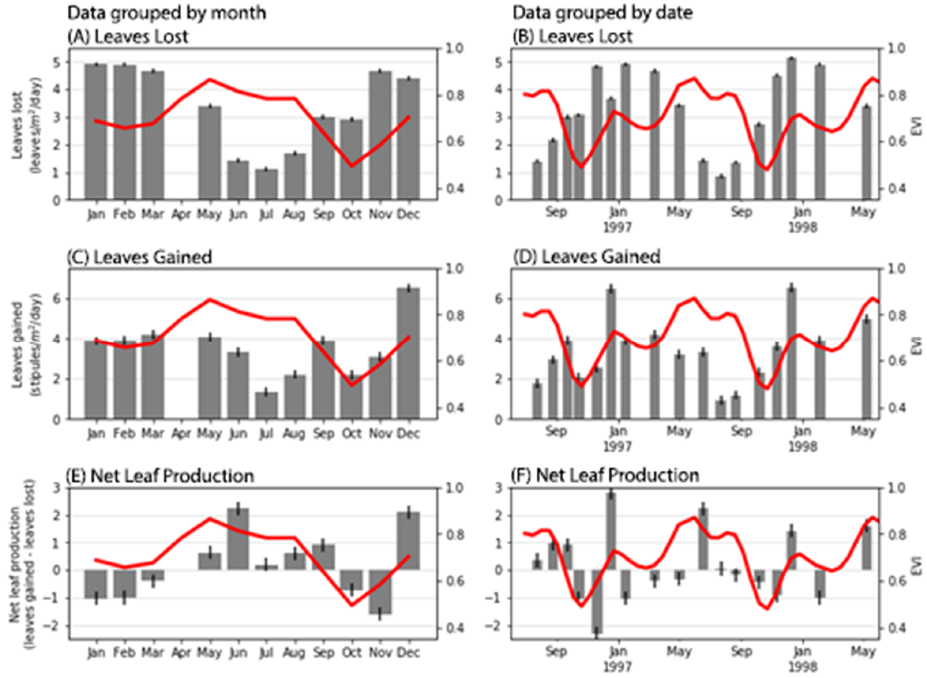
Figure 5. Apparent phenology vs. in situ data from [26]. The red line represents the apparent phenology for the Gladstone area (1995–1999). Grey bars and black lines represent the values for each variable and standard error, respectively. On the left panel, the data are grouped by month and on the right panel, the data are presented in chronological order. No in situ data were recorded for April during the experiment. Panels ( A , C and E ) display the monthly leaves lost, leaves gained, and net leaf production respectively. Panels ( B , D and F ) display the leaves lost, leaves gained, and net leaf production in chronological order.